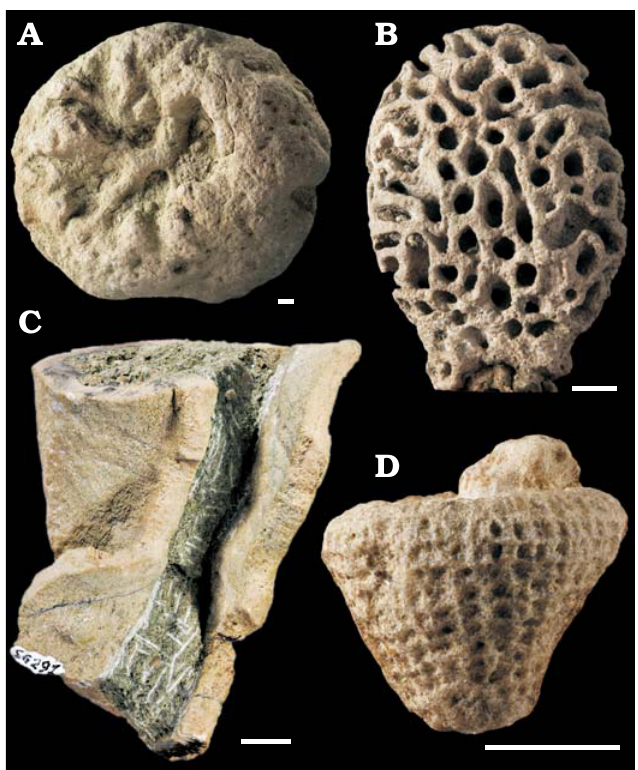
Fig. 1. Sponge fossils from the Eocene of Chiampo. A . The lyssacinosid Stauractinella eocenica Frisone, Pisera, and Preto, 2016. B . The lychnisco- sid Callicylix eocenicus Pisera and Busquets, 2002. C . The lithistid demo- sponge Platychonia sp. D . The hexactinosid Laocoetis patula Pomel, 1872. Scale bars 10 mm. Photos S.